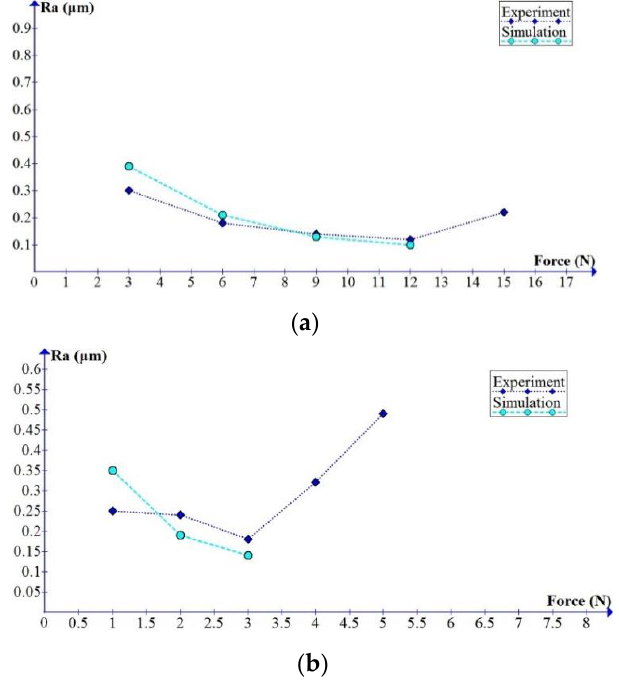
Figure 13. Comparison of the simulated and experimental relationships between the burnishing